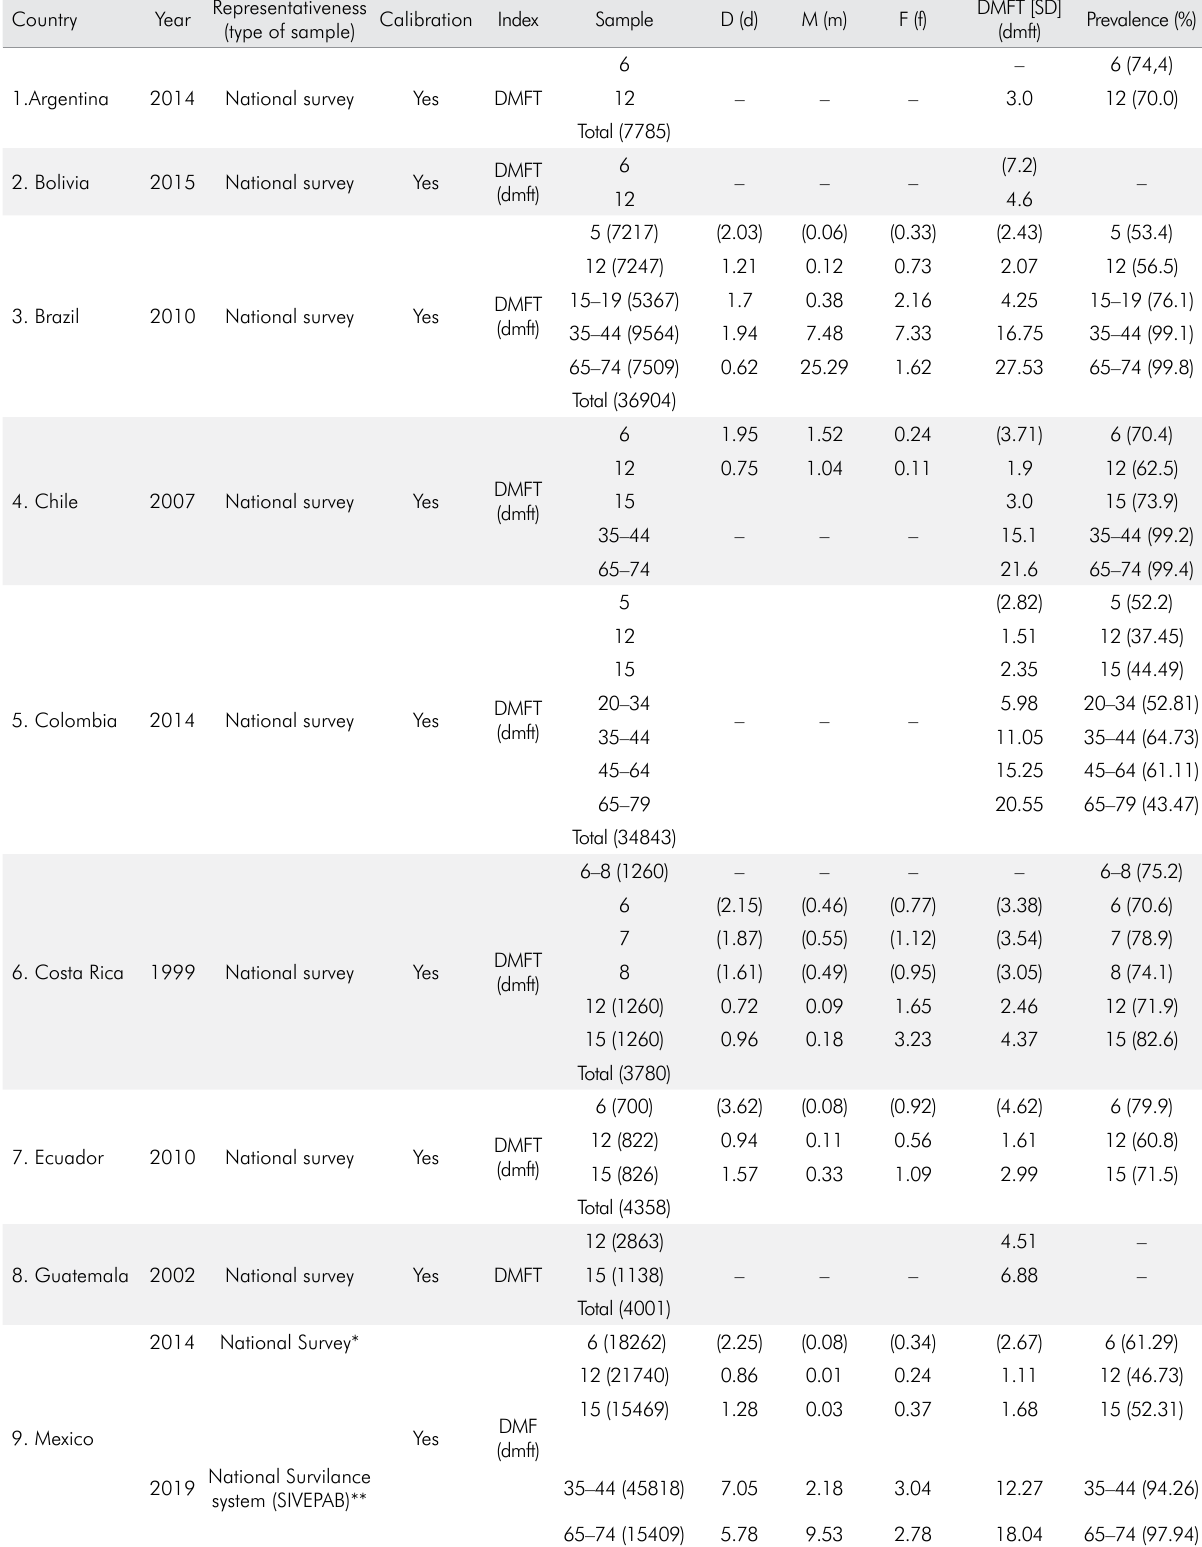
Table. Descriptive analysis of dental caries in LACC.